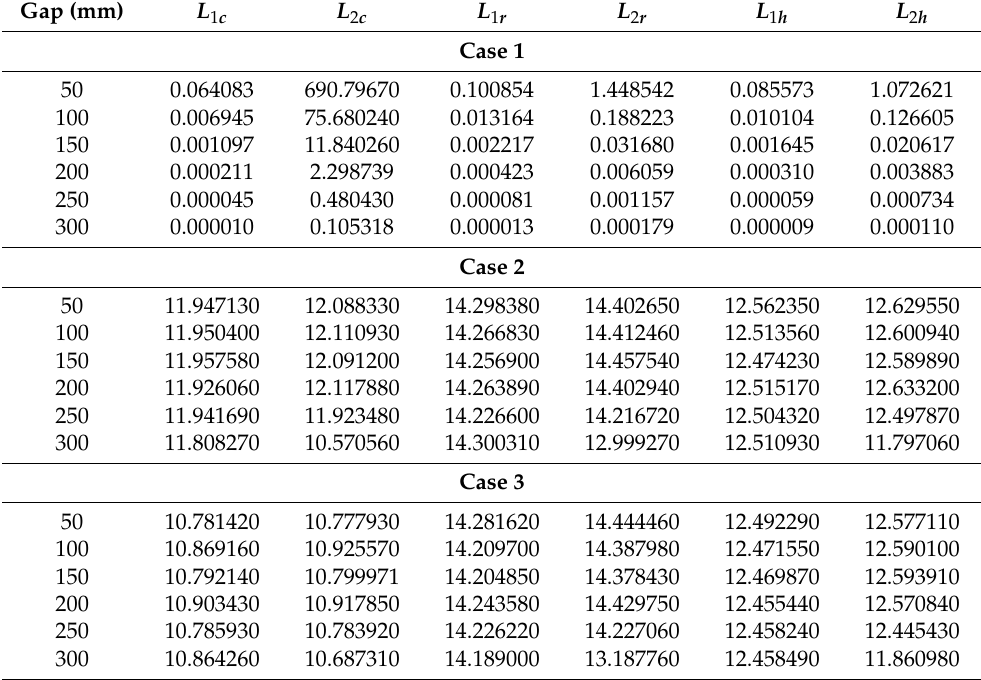
Table 12. The simulation results ( L 1 , L 2 ) of the three geometries: case 1, case 2, and case